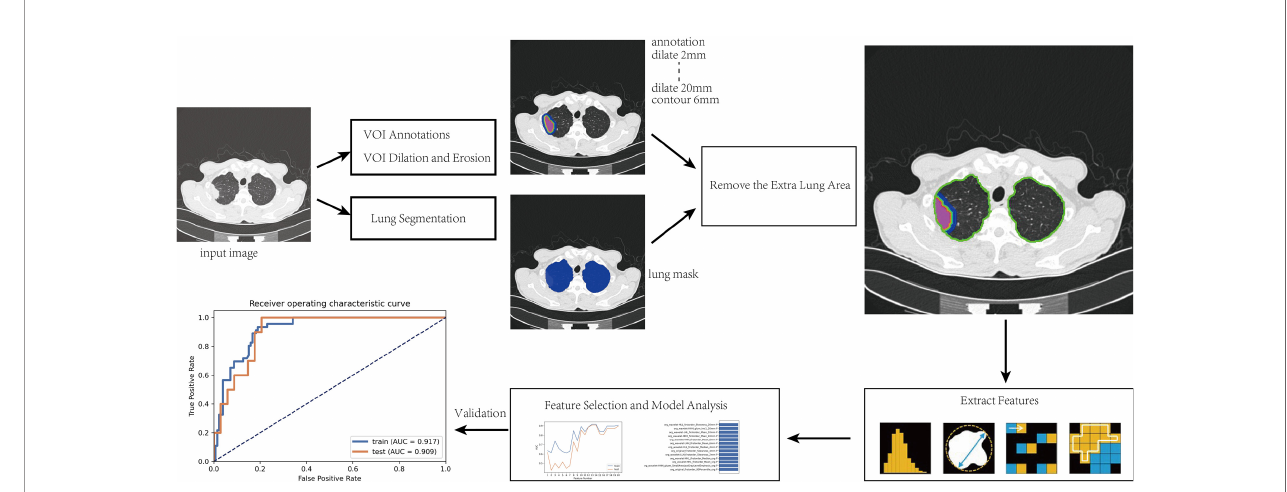
FIGURE 1 | Flowchart of radiomics procedure in this